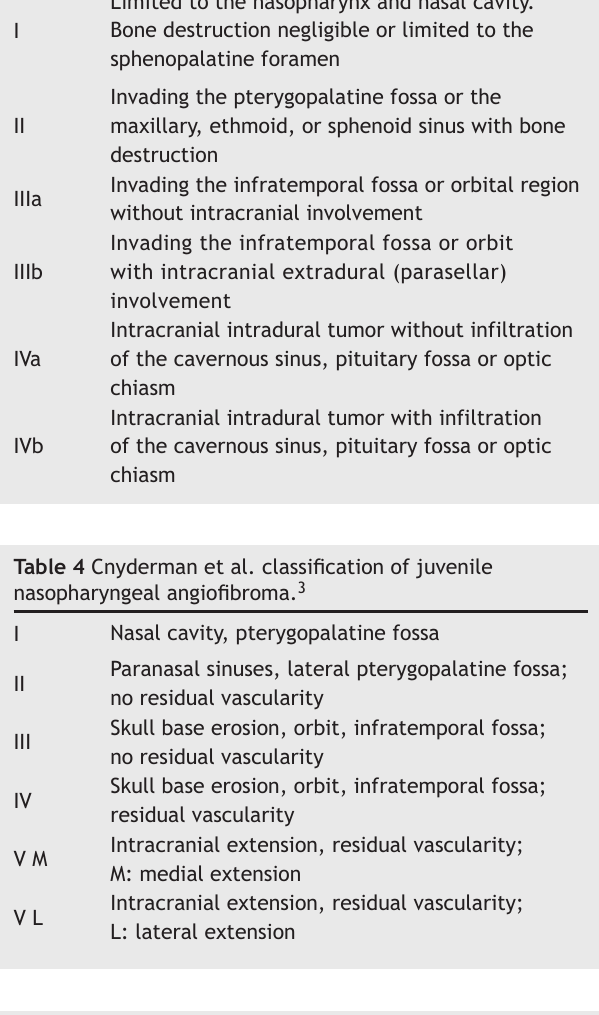
Table 5 Summary of tumor